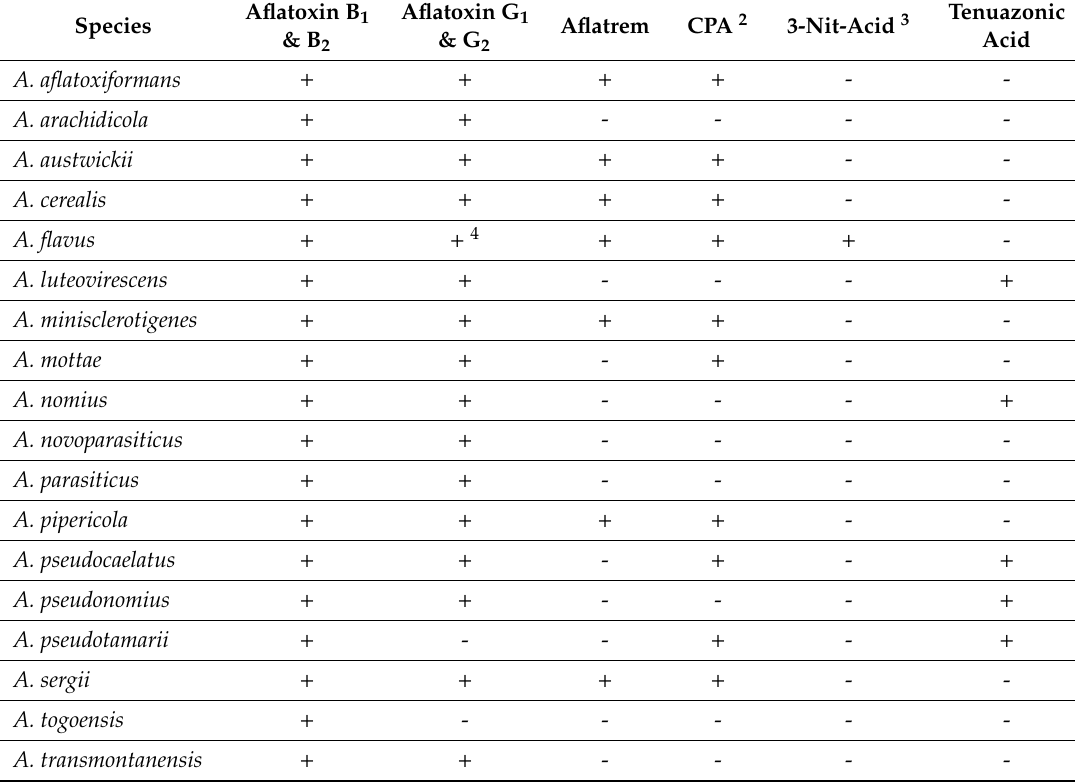
Table 1. Toxigenic profile of aflatoxin-producing species within Aspergillus section Flavi. 1